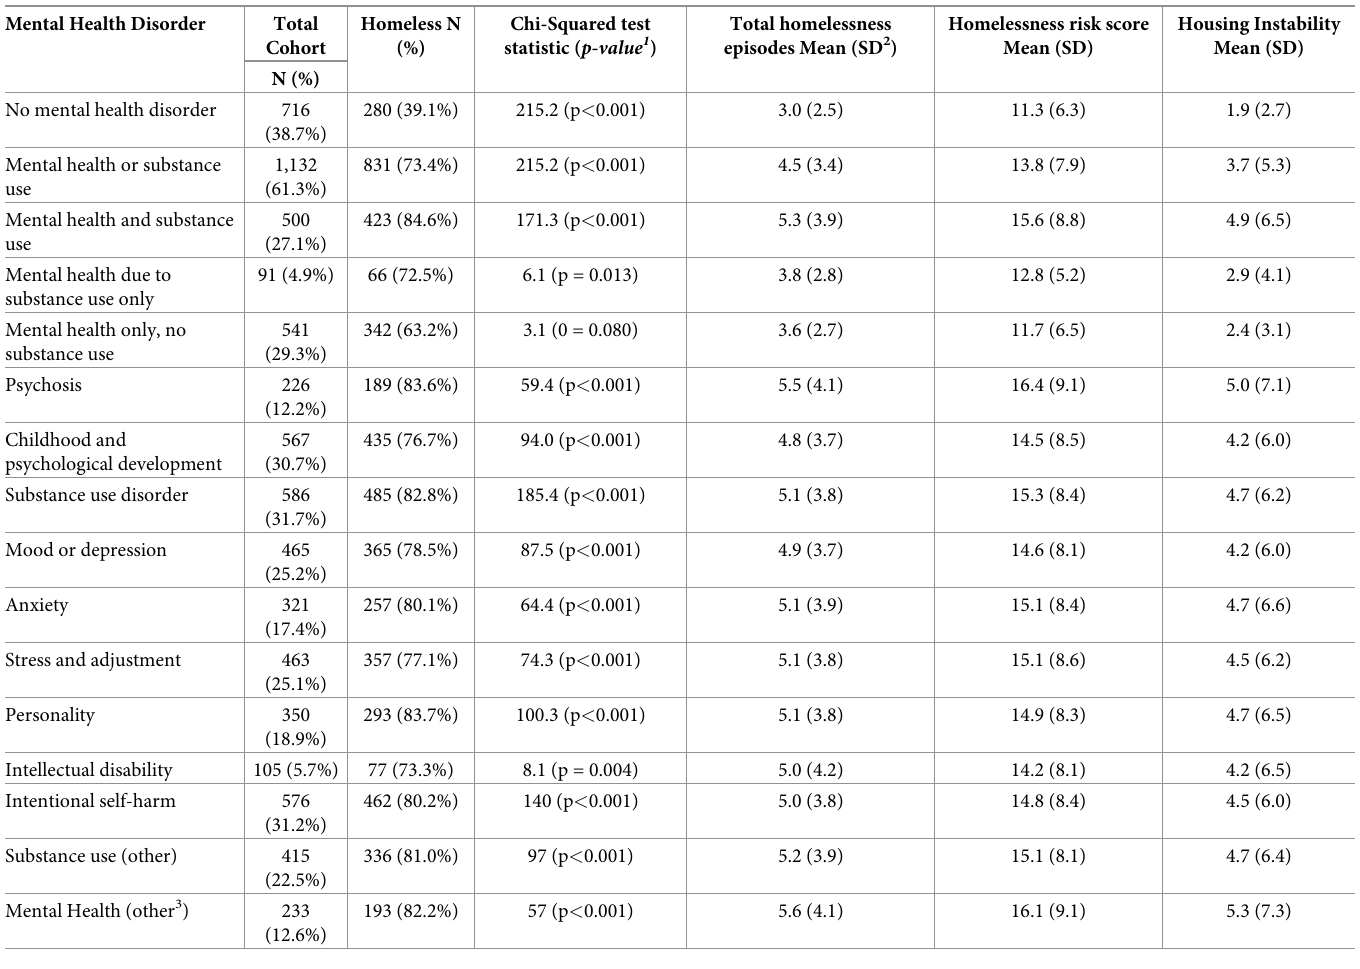
Table 3. Mental health characteristics for total cohort, homelessness and housing instability summaries and risk